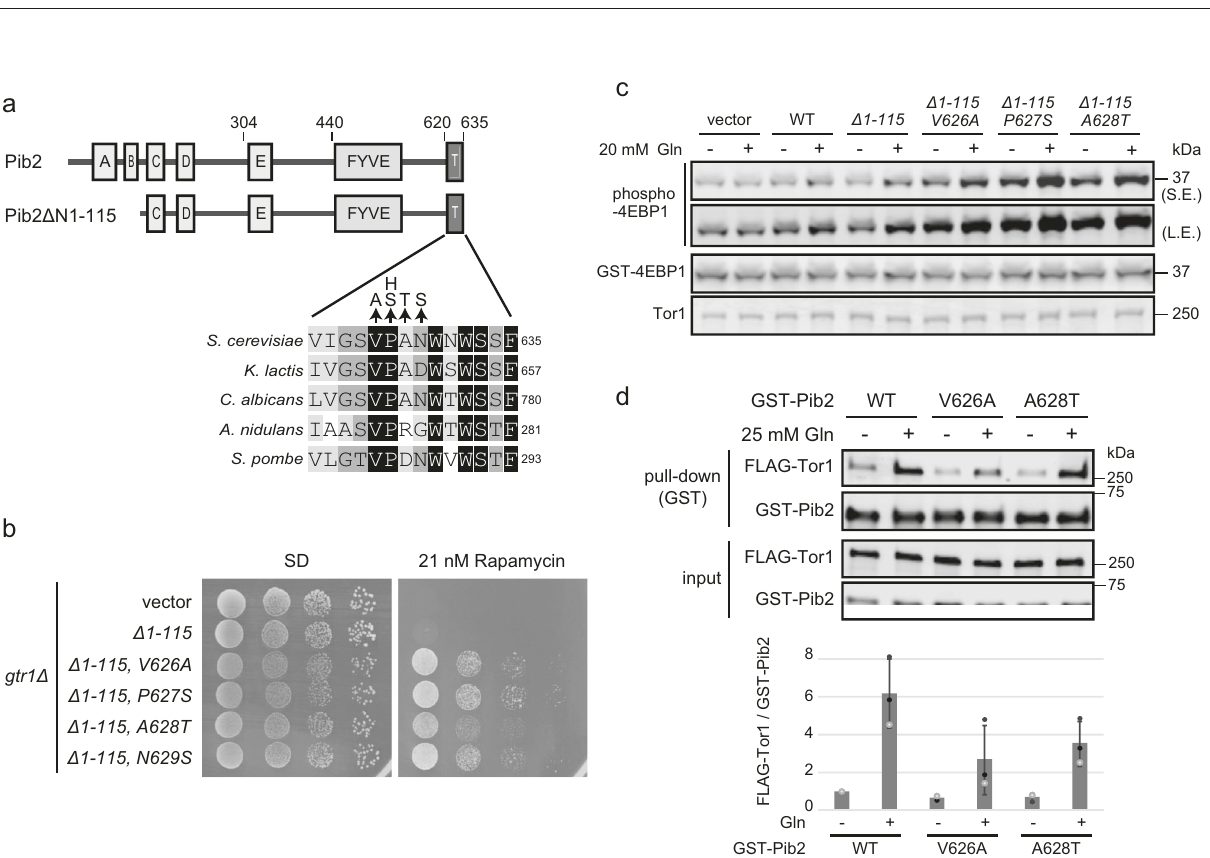
Fig. 3 Active PIB2 mutations are clustered in the conserved tail motif. a Schematic diagram of wild-type Pib2 and Pib2( Δ 1 − 115) was used for active mutant screening. Mutations in the active mutants from the tail motif are shown with multiple sequence alignments for different species. b Tail motif mutations confer yeast cells with rapamycin resistance. The gtr1 Δ strain (MH1030) was transformed with a vector (p416ADH) or plasmids encoding PIB2 mutants (pMH334, pKY11-1, pKY14-1, pKY24-1, or pKY21). Serially diluted cell suspensions were spotted on SD plates lacking uracil with or without 21 nM rapamycin and then grown at 30 °C for 3 (left) or 5 (right) days, respectively. c Pib2 active mutants enhance TORC1 activity in vitro. An in vitro TORC1 kinase assay was performed (as for Fig. 1d) using permeabilized yeast cells prepared from pib2 Δ (MH1059) cells carrying a vector (p416ADH) or plasmids encoding wild-type PIB2 (pMH330) or PIB2 mutants (pMH334, pKY11-1, pKY14-1, pKY24-1, or pKY21). L.E long exposure, S.E short exposure. d The interaction between active Pib2 mutants and TORC1 is glutamine-responsive. Pull-down assays were performed using yeast cell lysates and bacterially- expressed GST-Pib2 tail motif mutants (as in Fig. 1b). The bar graph shows GST-Pib2-bound FLAG-Tor1 normalized to the wild-type Pib2 samples without glutamine. Error bars represent the standard deviation ( n = 3 independent